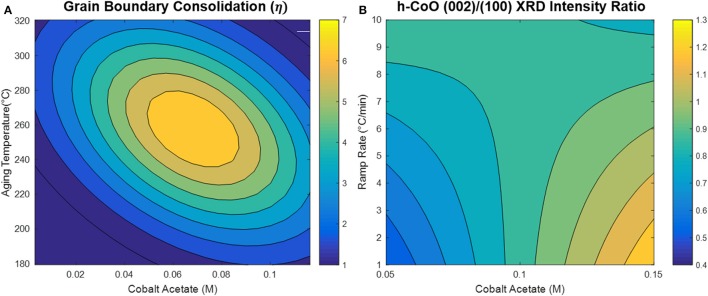
(A) Grain boundary consolidation contour map developed with CCD and (B) h-CoO (002)/(100) XRD intensity ratio contour map generated with screening design.